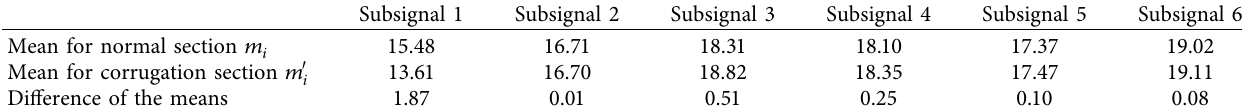
Table 3: The columnwise means of the Renyi entropy and the difference of the means for the normal section and corrugation section.